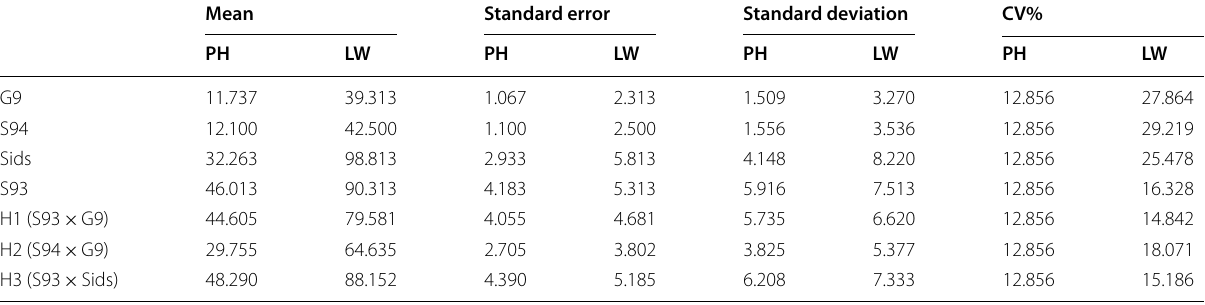
Table 2 Mean, standard error, standard deviation, and coefficient of variance of parents and their crosses for plant height (PH) and leaf wilting (LW) traits